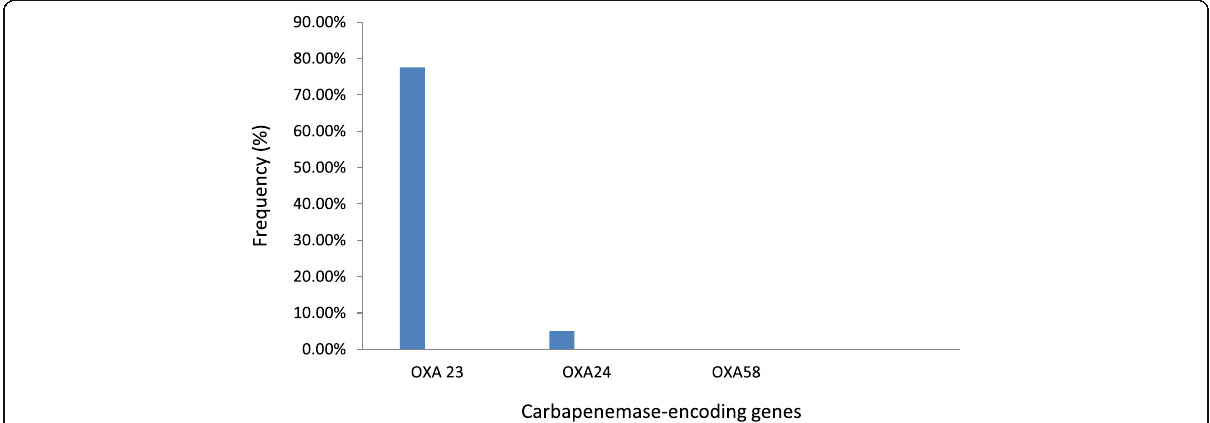
Fig. 1 Frequency of detection of different groups of carbapenemase-encoding genes in A. baumannii